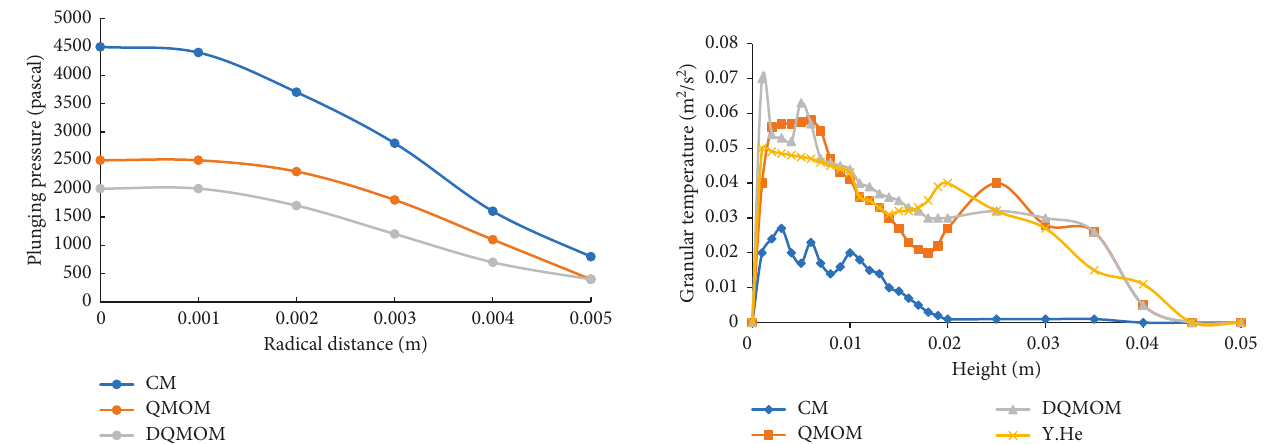
Figure 8: The granular temperature in the axial direction along the nozzle